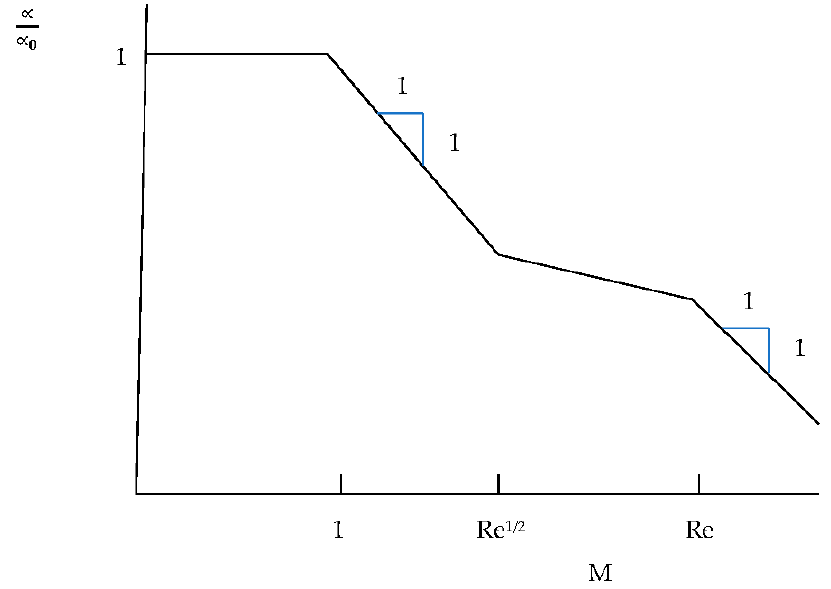
Figure 1. The effect of Mach number on spreading angle of the free shear layer according to the model. There are three transitions between different regimes. The first occurs when the size of the sonic eddy equals the largest possible vortex size, at M = 1. The sonic eddy becomes as small as the smallest possible eddy, the Kolmogorov microscale, when the Mach number is equal to the square root of the Reynolds number, as described in [4]. The third transition occurs at M = Re, when the sonic eddy equals the mean free path of the